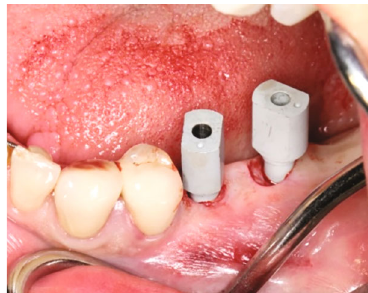
Figure 13: Veri fi cation of the implant axes (yellow pins) for implants 35 and 36 and comparison with the prosthetic digital crown